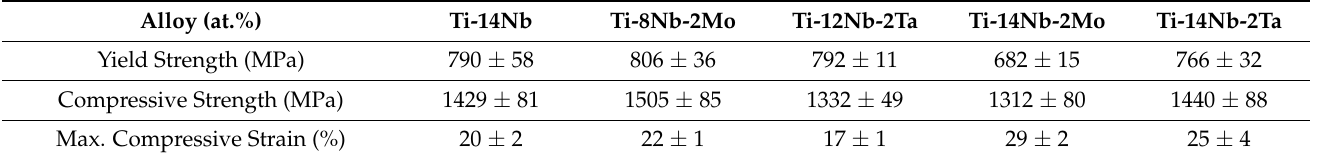
Table 1. Mechanical properties of the investigated materials. Alloy (at.%)